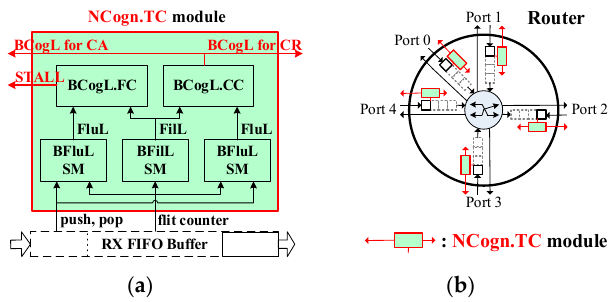
Figure 11. ( a ) NCogn.TC module ( b ) incorporated in a typical five-port router.